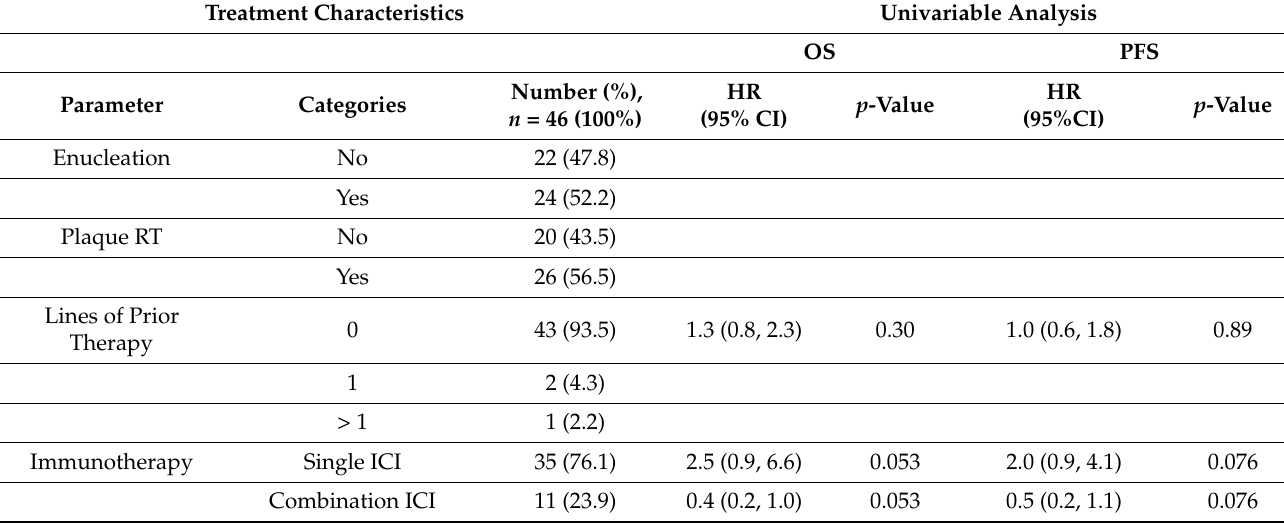
Table 2. Treatment